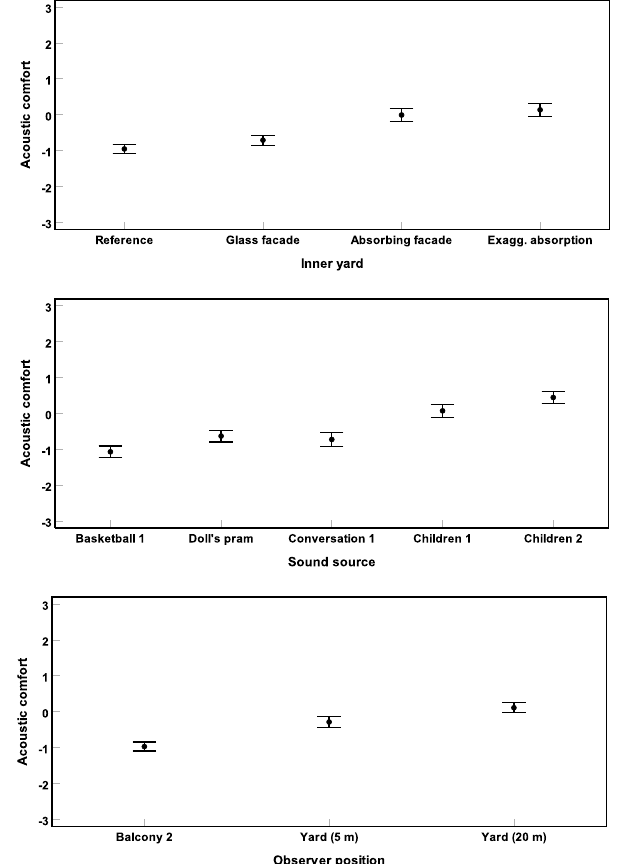
Figure 4. Results of Experiment 1: Mean acoustic comfort ratings across subjects and their 95% confidence intervals are shown for different inner yards ( above ), sound sources ( middle ), and observer positions ( below